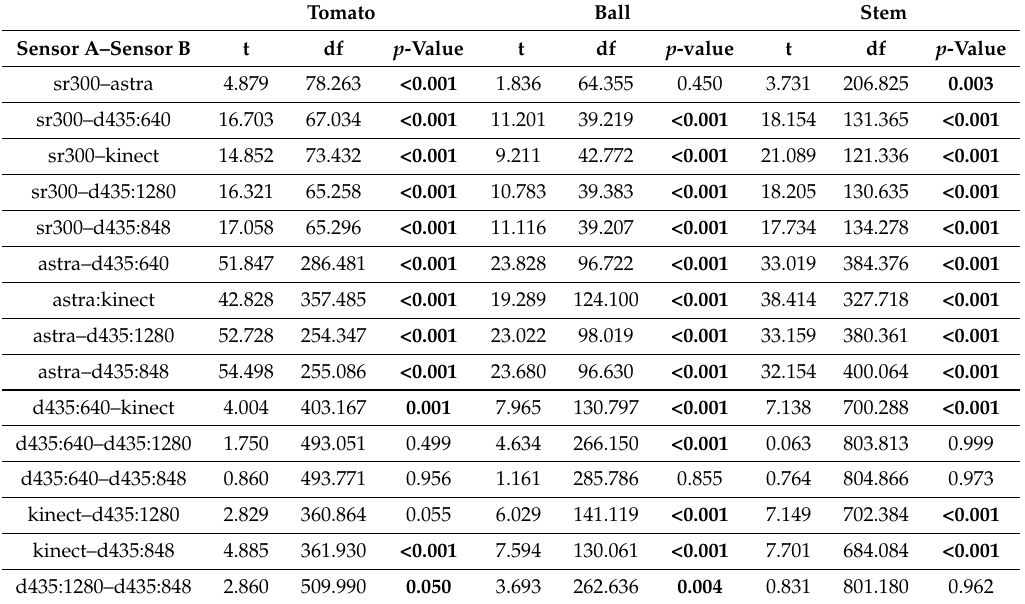
Table 2. Games–Howell test results for tomato, ball and stem. Bolded results are significant at the 0.05 level.